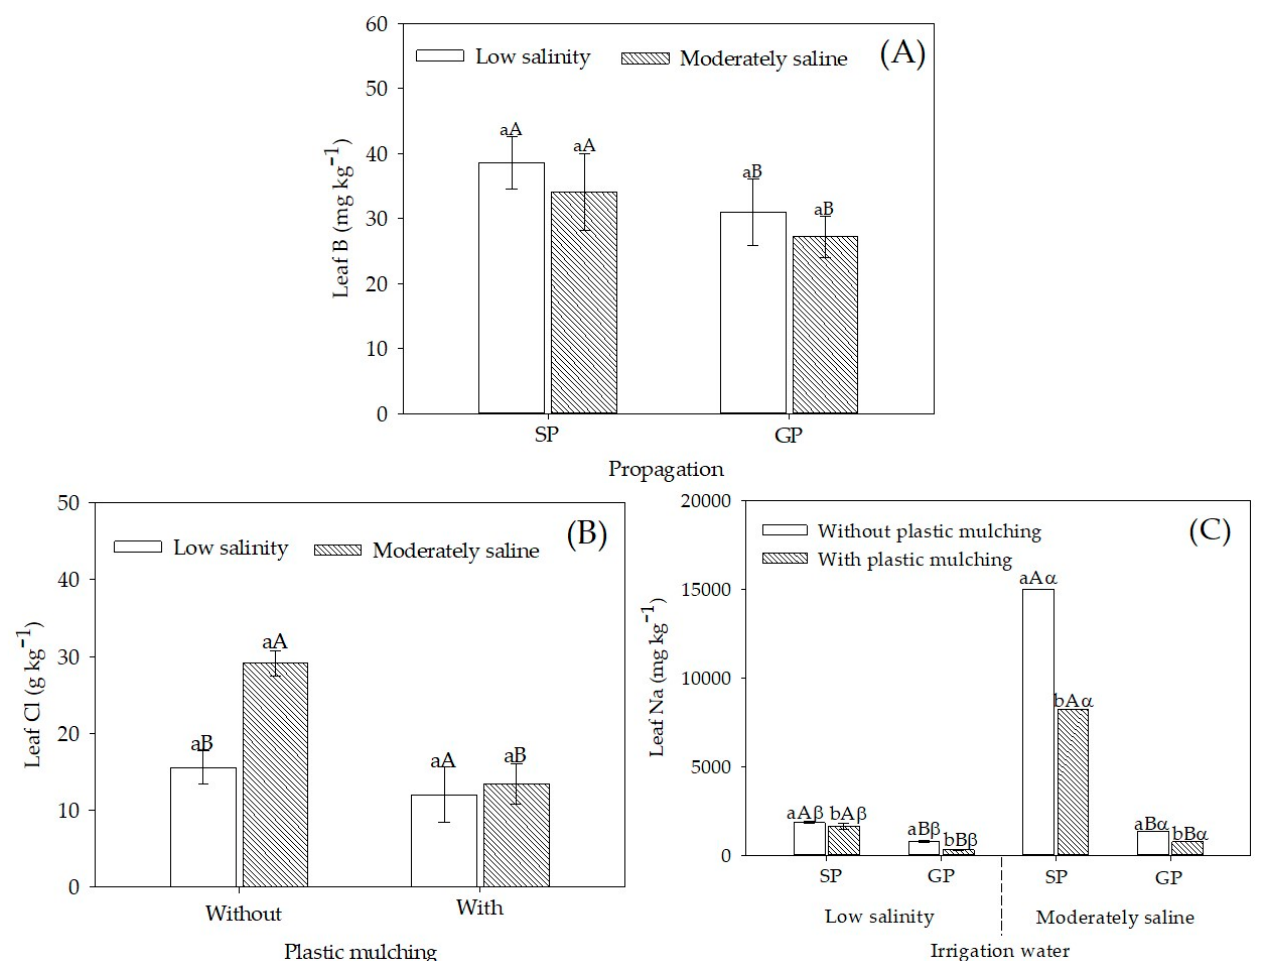
Figure 4. Concentration of micronutrients (boron and chlorine) and sodium in leaves of sour passion fruit by seed-propagated and grafted propagated, irrigated with low salinity and moderately saline waters, with and without plastic mulching. ( A ) B concentration in sour passion fruit seed-propagated (SP) and grafted propagated (GP) on Passiflora cincinnata irrigated with low salinity and moderately saline water; ( B ) Cl concentration in sour passion fruit irrigated with low salinity and moderately saline water in soil with and without plastic mulching; ( C ) Na concentration in sour passion fruit seed-propagated (SP) and grafted propagated (GP) on Passiflora cincinnata irrigated with low salinity and moderately saline water in soil with and without plastic mulching. Vertical bars represent the standard error of the mean (n = 4). Bars with the same lower-case letter are similar for soil with and without plastic mulching ( A ) or low salinity and moderately saline irrigation water ( B , C ) by the F-test ( p > 0.05). Bars with the same uppercase letter are similar for soil with and without plastic mulching ( B ) or seed propagation and grafting ( A , C ) by the F-test ( p > 0.05). Bars with the same Greek letter are similar for irrigation with low saline and moderate saline water ( A ) by the F-test ( p > 0.05).